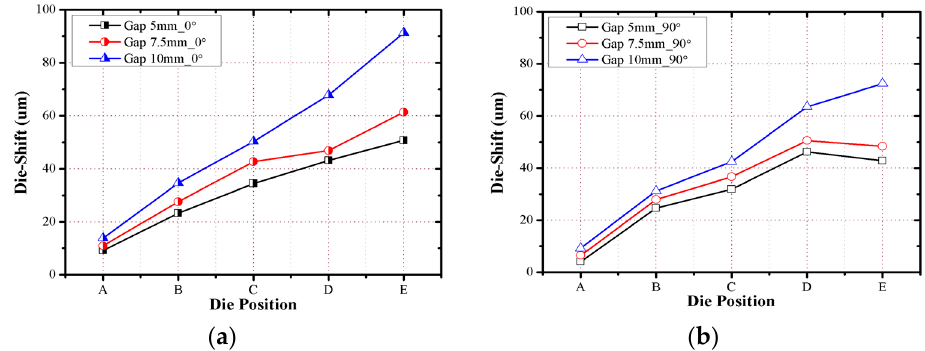
Figure 10. Die shift measurement results after the debonding process: ( a ) 0° direction; ( b ) 90° direction.